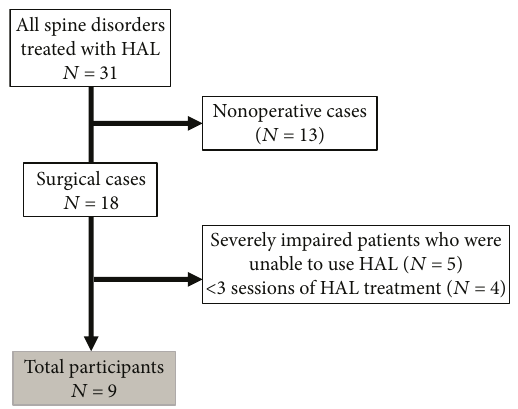
Figure 1: Patient selection fl